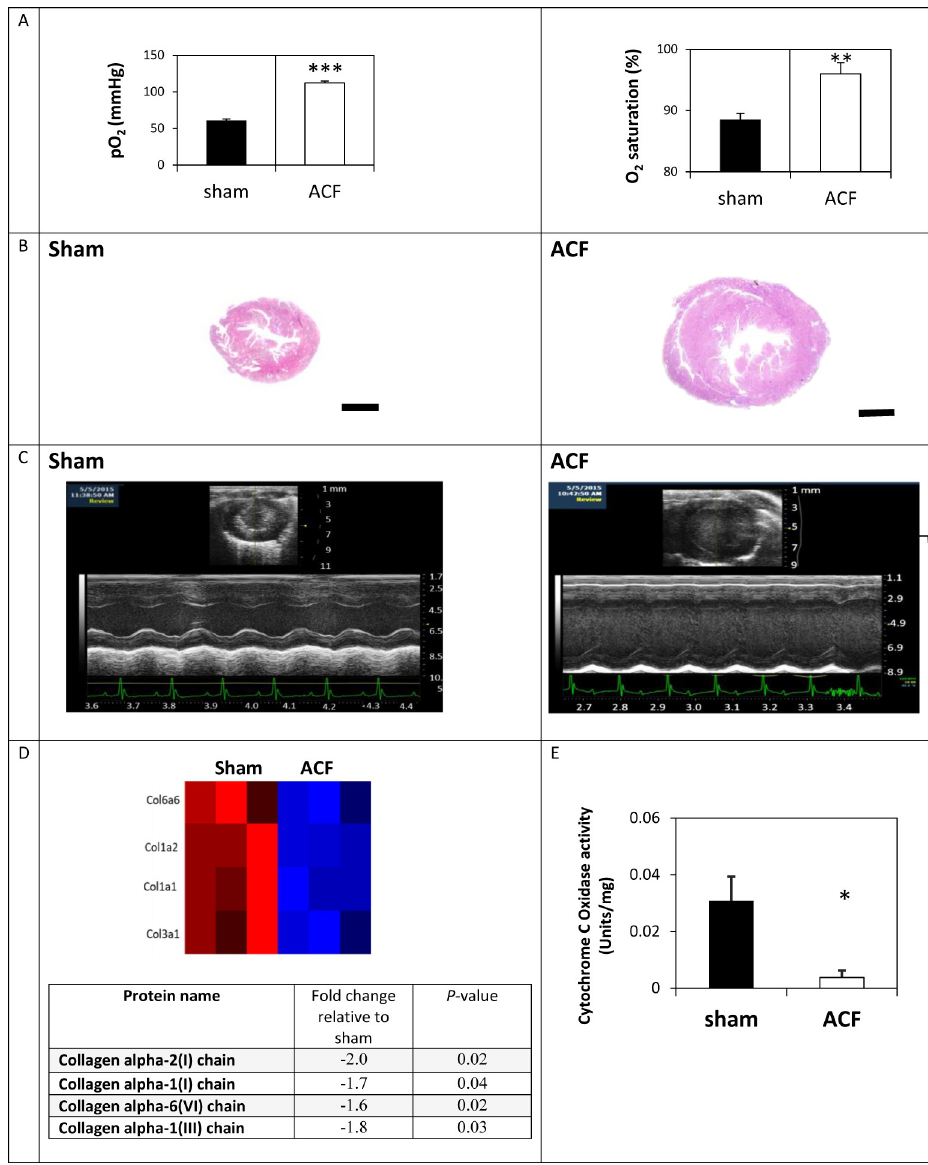
Fig 1. Cardiac dilatation in mice subjected to ACF. (A) Partial oxygen pressure and oxygen saturation at the vena cava one day post-surgery (n = 6 mice per group). (B) Masson’s trichrome–stained transverse cardiac sections four weeks post-surgery (representative captures). Scale bar: 1 mm. (C) Representative echocardiographic M-mode images of the same animals. (D) Expression profile of collagen proteins in cardiac sections of sham and ACF animals according to mass spectra analysis. The color scale is ranging from blue (reduced expression) to red (induced expression). (E) Cytochrome C oxidase activity in isolated mitochondria from sham and ACF hearts (n = 5 per group). Data are given as means ± SEM; � P < 0.05, �� P < 0.01; ��� P < 0.001.